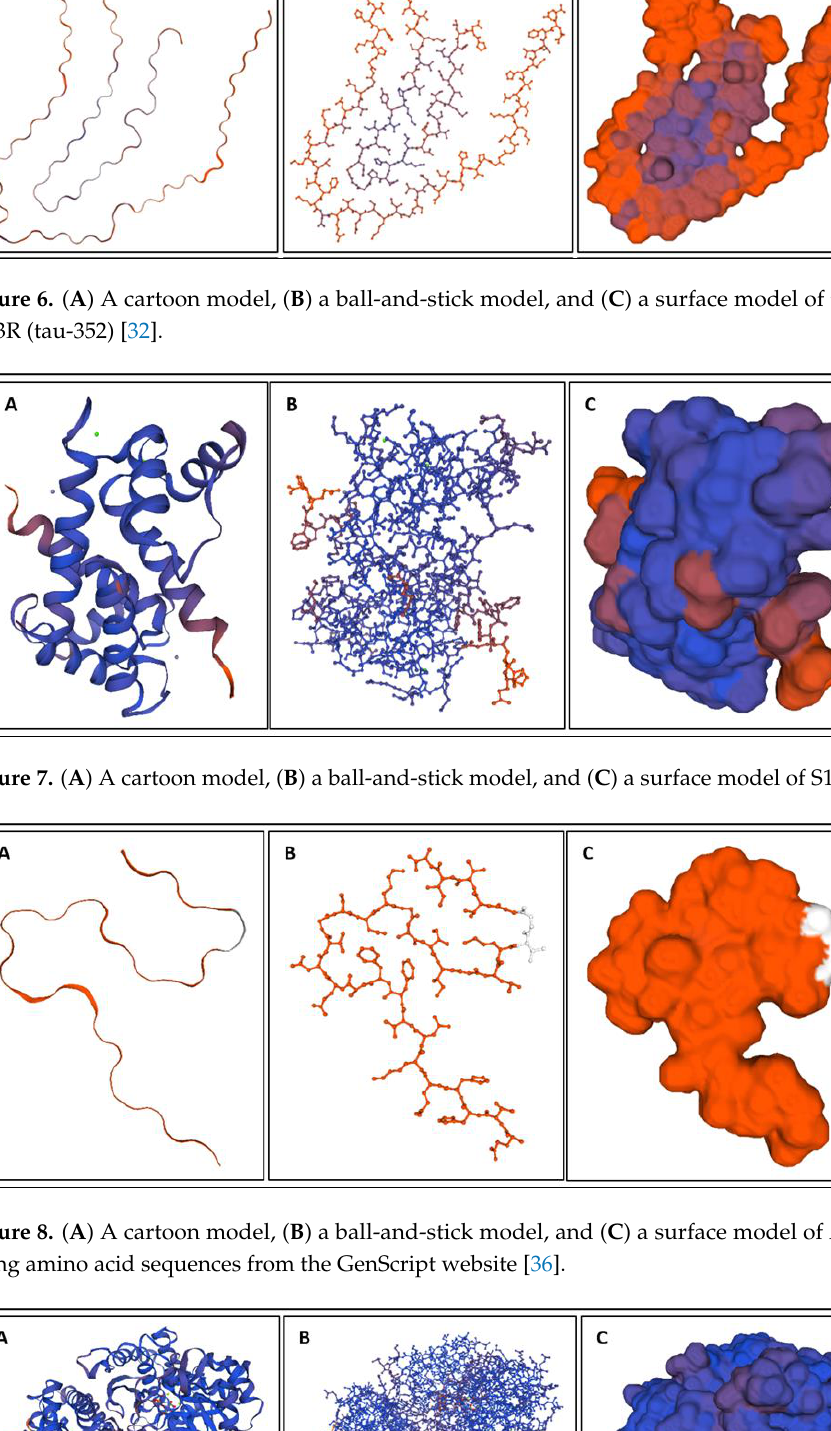
Figure 10. ( A ) A cartoon model, ( B ) a ball-and-stick model, and ( C ) a surface model of CRP made using amino acid sequences from the UniProt database [40].